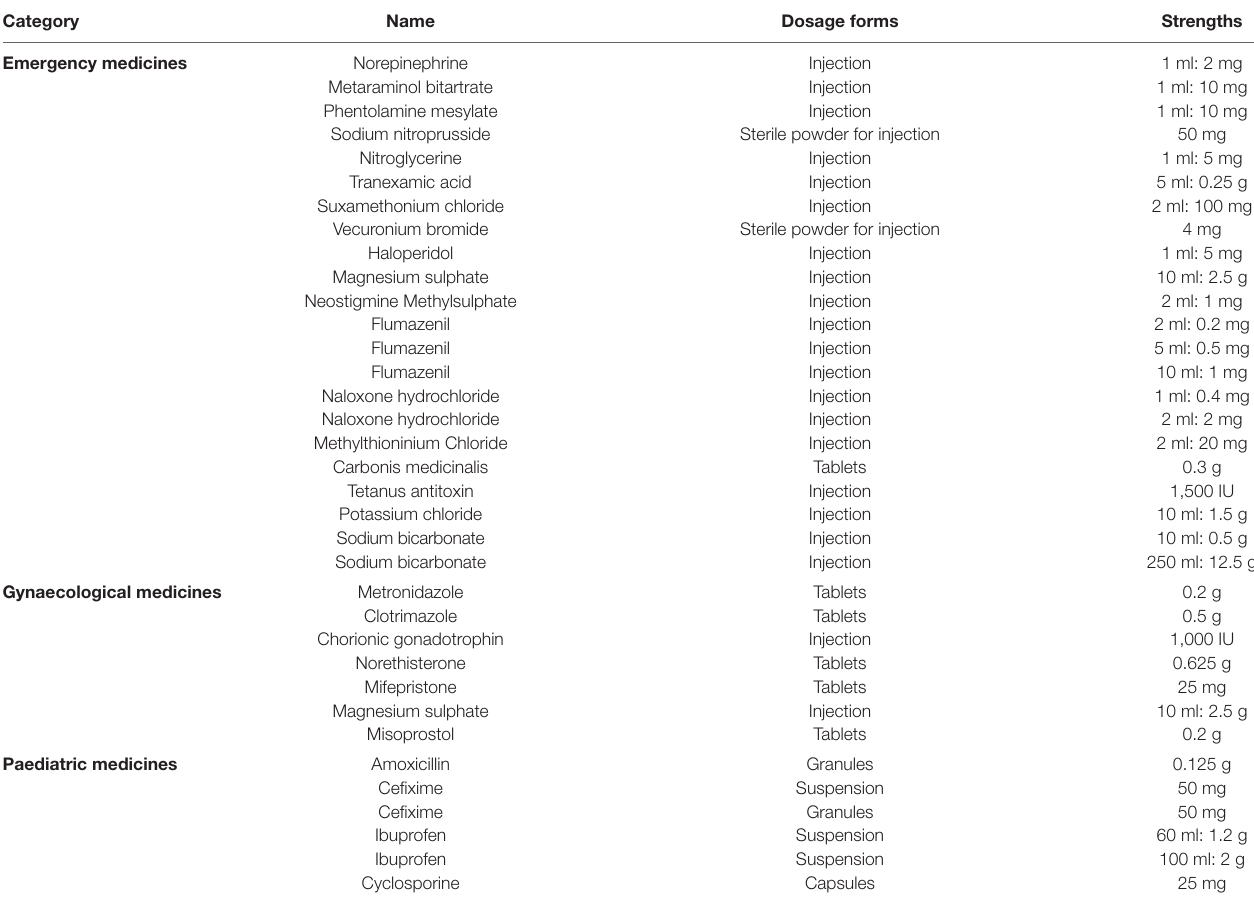
TABLE 2 | The information of all the 35 medicines. Category